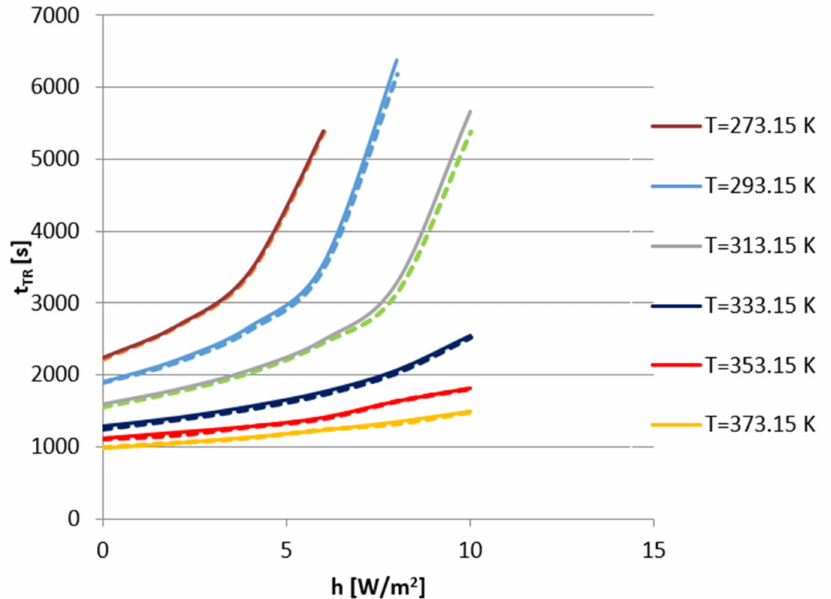
Figure 3. Thermal runaway ignition time (t TR ) as a function of h and ambient temperature for the LCO cathode. Solid lines = literature data [75]; dashed lines = present model results.